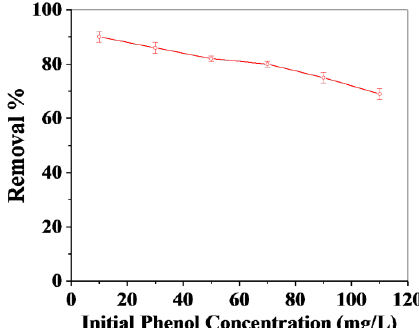
Figure 7. Effect of the initial concentration of phenol on the adsorption performanceof phenol on GO– cellulose composite:adsorbent = 125 mg; shaking time = 40 min; pH = 7; and temperature = 50 °C. 4. Comparison of Phenol Removal with Various Adsorbents Reported in the Litera- ture